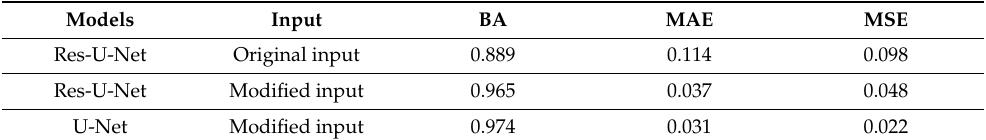
Table 3. Dependency between accuracy and features.